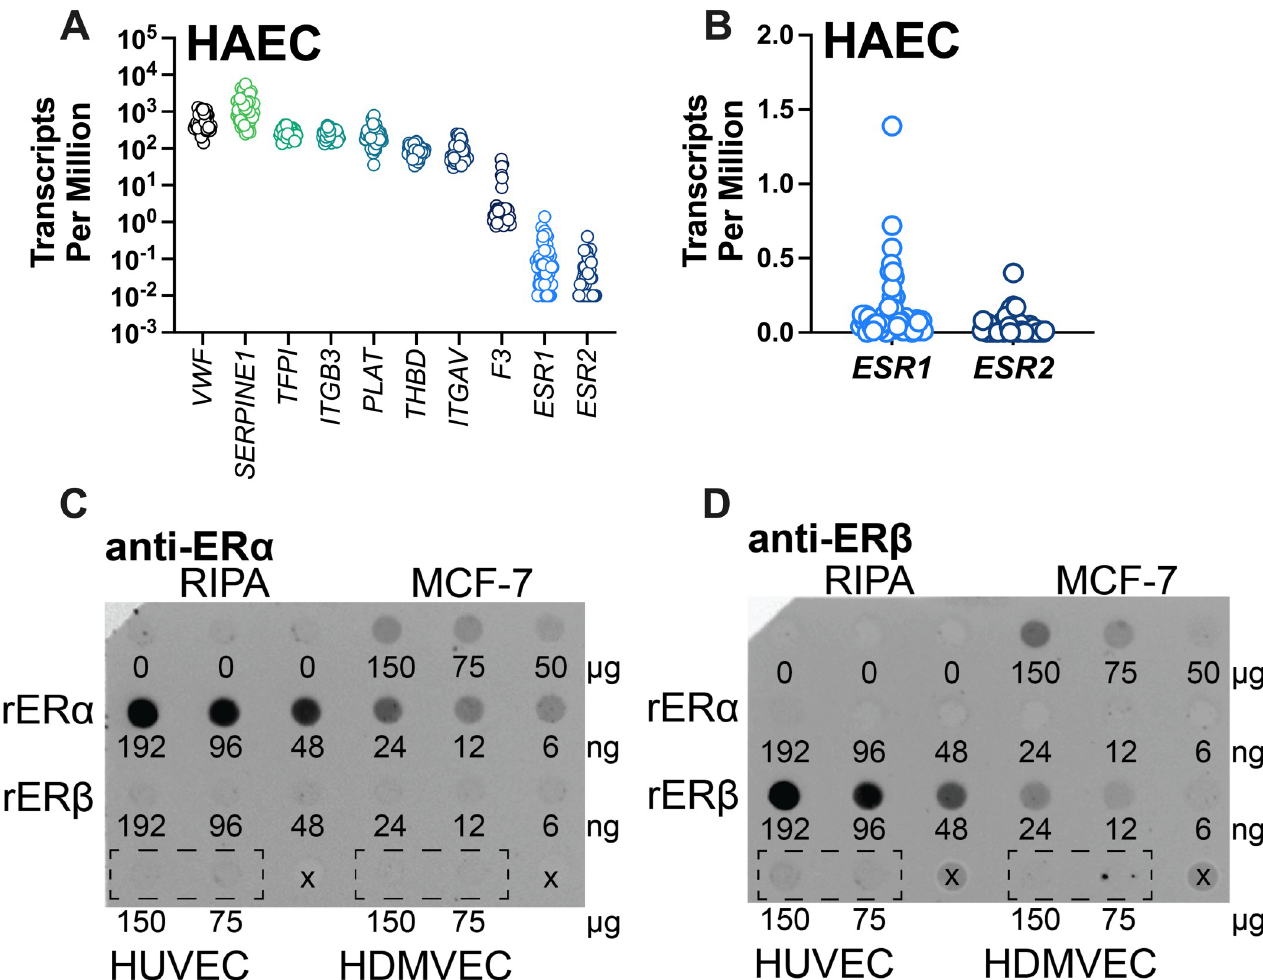
Fig 3. Primary ECs have low, variable levels of estrogen receptor gene expression. (A) RNA-seq data from aortic EC were mined for coagulation genes of interest. (B) Estrogen receptor gene expression shown on a linear scale. HUVEC and HDMVEC whole cell lysates were probed for (C) ER α and (D) ER β protein, using MCF-7 cell lysates and recombinant ER α and ER β as positive controls. Empty wells are marked with an x. Blot is representative of N = 3.